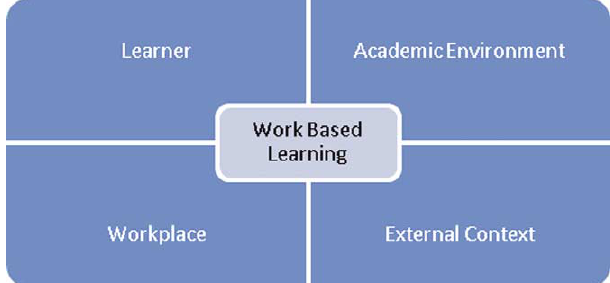
Figure 1. WBL and the stakeholder